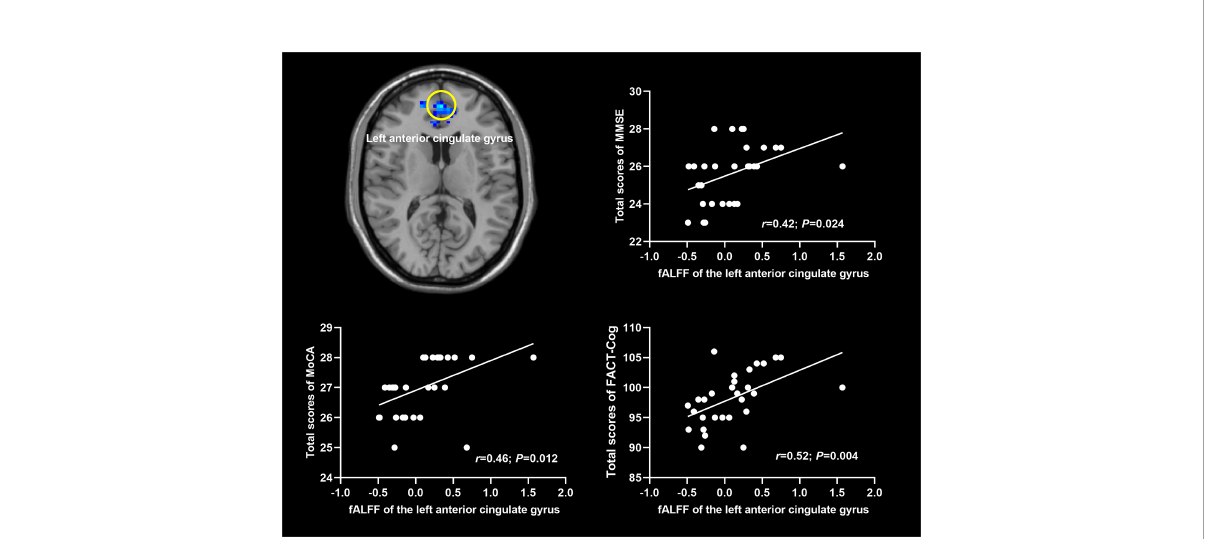
FIGURE 3 Correlations between fALFF and scores of cognitive scales. fALFF: fractional amplitude of low-frequency fl uctuation. MMSE: Mini Mental State Exam; MoCA: Montreal Cognitive Assessment; FACT-Cog: Functional Assessment of Cancer Therapy-Cognitive Function. The signi fi cance level was set at P